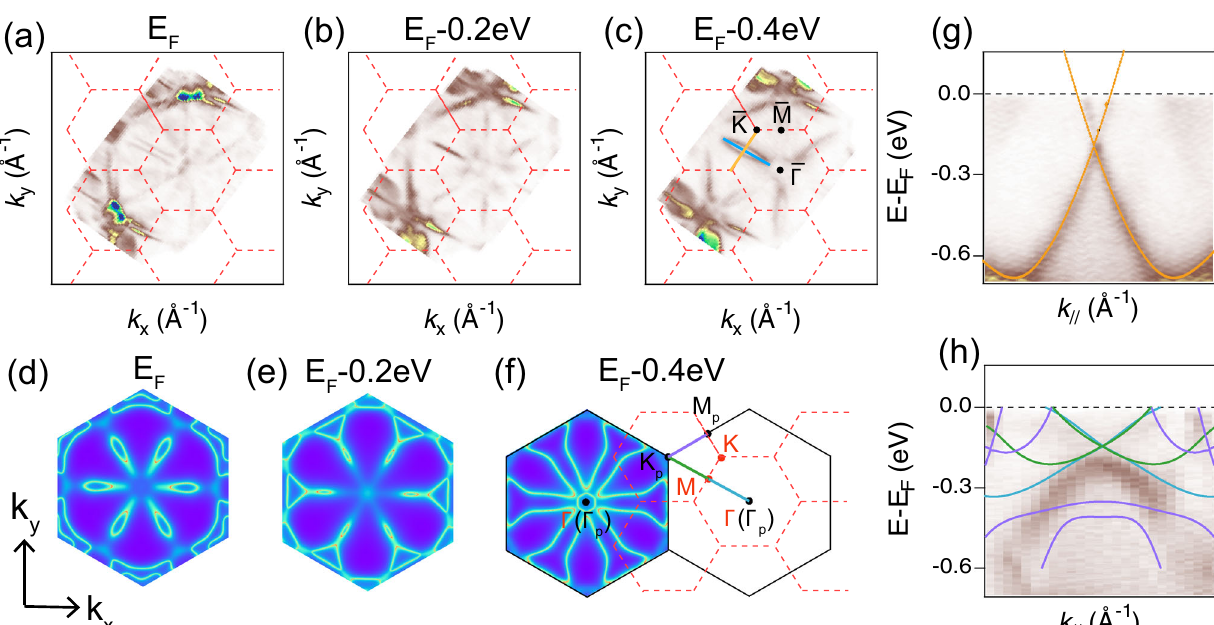
Fig. 3 Fermi surface and band dispersion obtained from ARPES measurements and DFT calculations. a – c Fermi surface mapping with energy of E F , E F − 0.2 eV and E F − 0.4 eV. Γ is the center momenta in the fi rst surface BZ. d – g DFT calculations on the Fermi surface mapping with k z = π , which correspond to the energies in ( b – d ). We note that the BZ in ( a – c ) are with hexagonal type lattice, i.e., conventional cell of Ni 3 In 2 S 2 , which will be three times smaller than the rhombohedral BZ used in the DFT calculation. BZ folding from the DFT calculated one (black hexagon) to the experimental one (red dashed hexagon) is shown in ( f ). g , h are two bulk band cutting marked in ( c ), with k ∥ follow the yellow and blue lines,